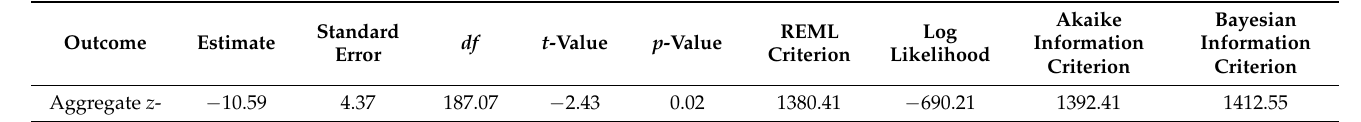
Table 3. RN Hours per Resident Day and Quality of